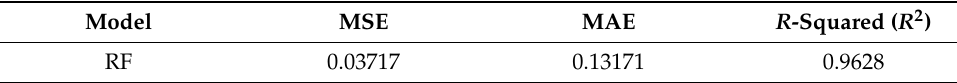
Table 14. RF performance